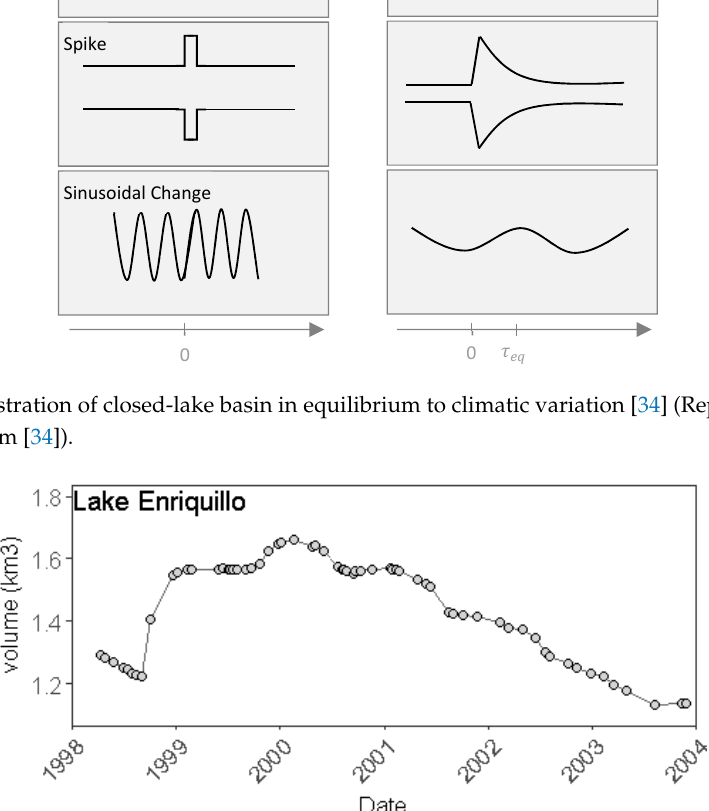
Figure 13. Lake Enriquillo’s response to the hurricane George on between the years of 1998 to 2004.